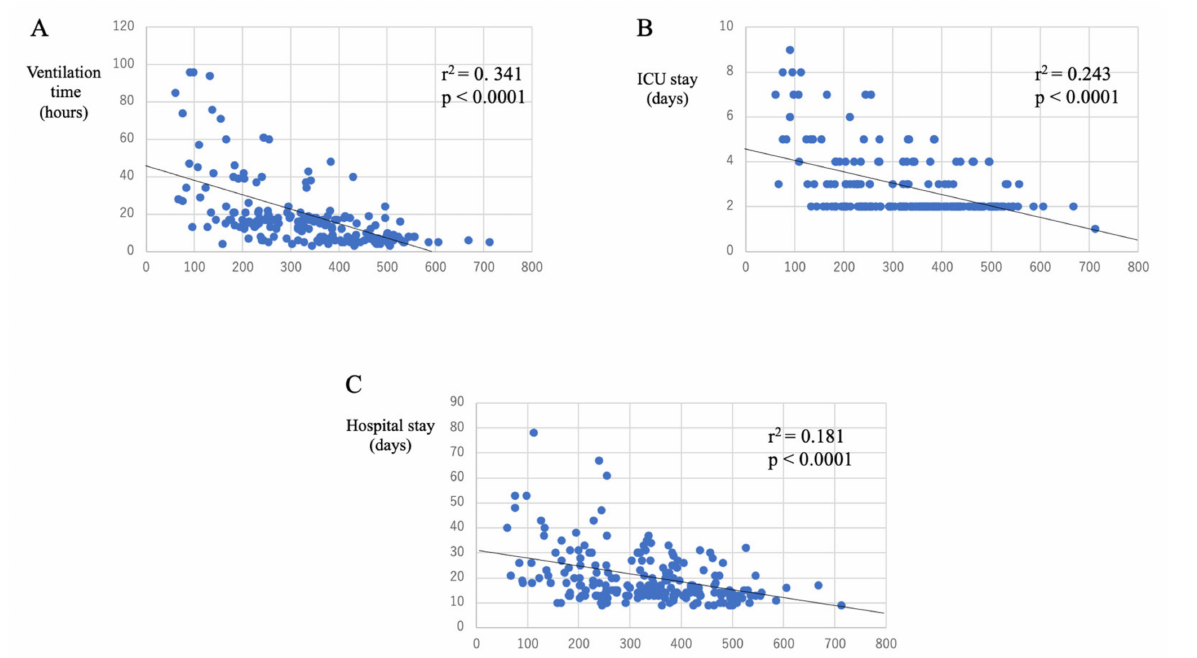
Figure 2. Correlations between PaO 2 /FiO 2 (PFR) and postoperative course. PFR is positively correlated with DMV ( A ), ICU stays ( B ), and hospital stays ( C ). DMV, duration of mechanical ventilation; ICU, intensive care unit.